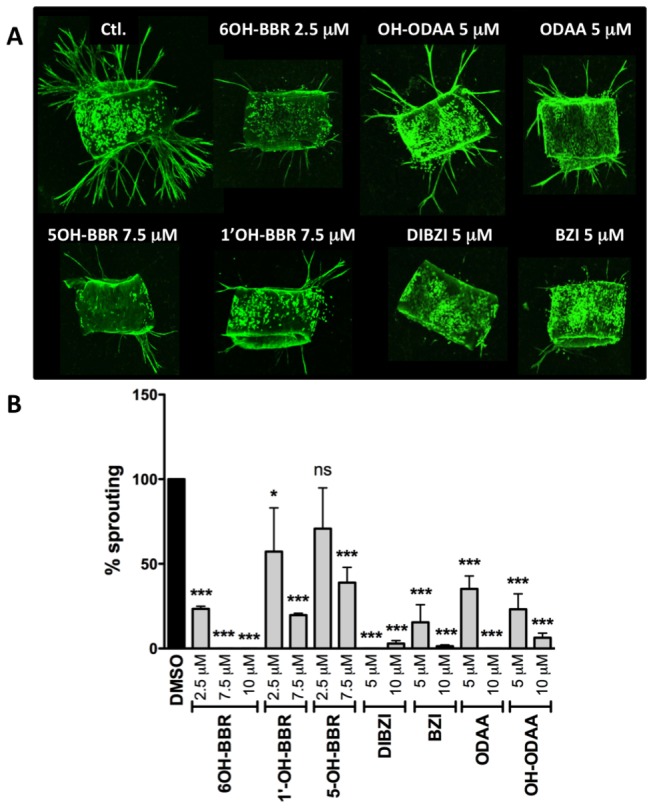
Effect of test compounds on aortic ring sprouting.(A) Representative images of isolectin-stained aortic rings treated with either vehicle controls or the indicated concentration of various test compounds. (B) Quantitation of the number of sprouts per ring with each bar representing at least 4 rings. *** P<0.001, ** P<0.01, * P<0.05, ns not significant).